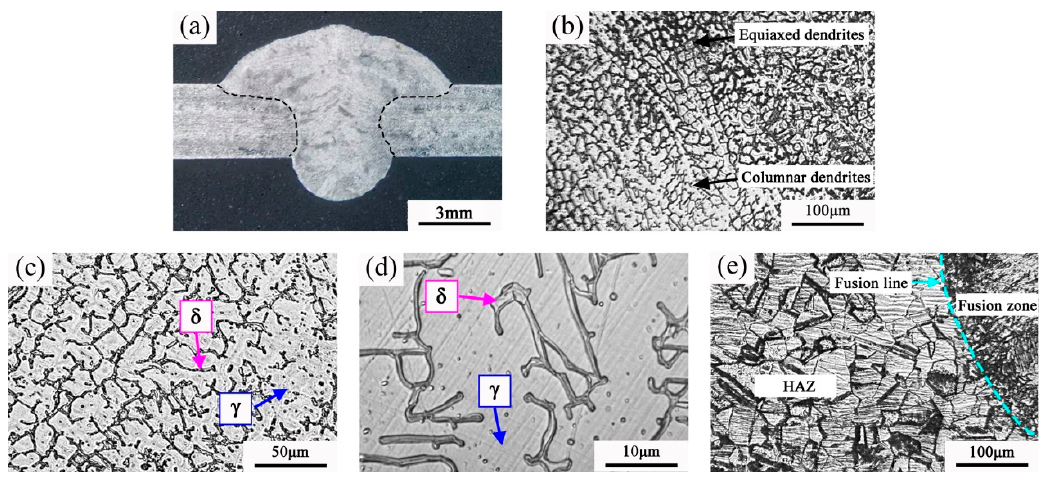
Figure 16. Optical micrographs of microstructure and heat affected zone (HAZ) of P-GMAW (No.12): ( a ) weld cross-section; ( b ) typical microstructure of P-GMAW weld, ( c ) coarse austenite columnar structures, ( d ) ferrite morphology and ( e ) HAZ.